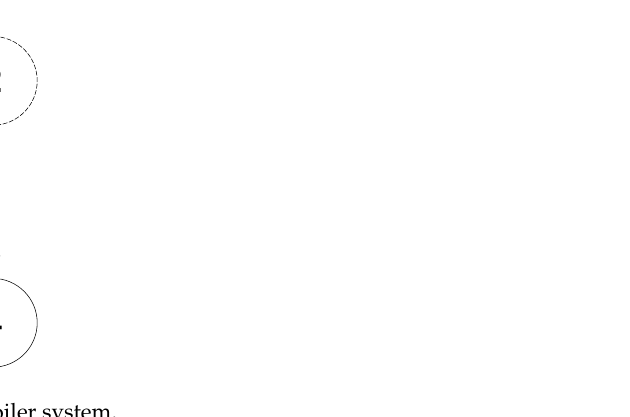
Figure 3. Structure of the multi-boiler system.